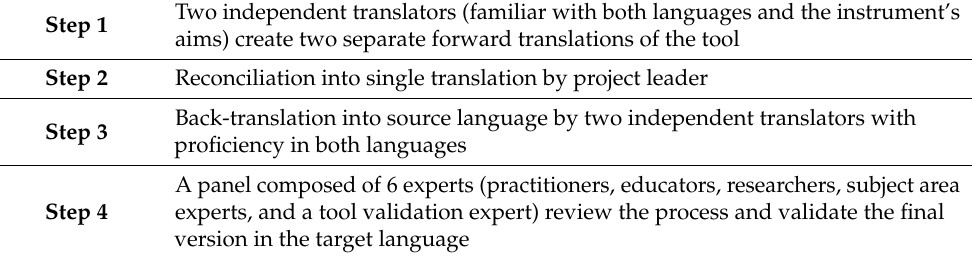
Table 1. Forward-backward translation procedure